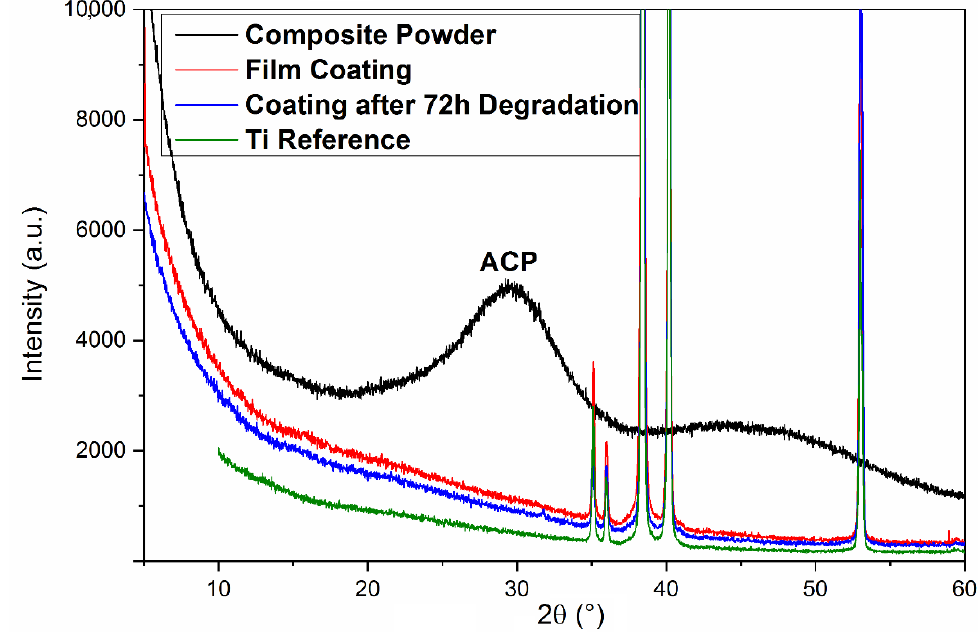
Figure 6. XRD diffractograms of: Ti substrate (green); ACP/CHT/TC composite powder (black); ACP/CHT/TC as-deposited film (red); and MAPLE composite coating after 72 h of immersion in SBF at 37 °C (blue).